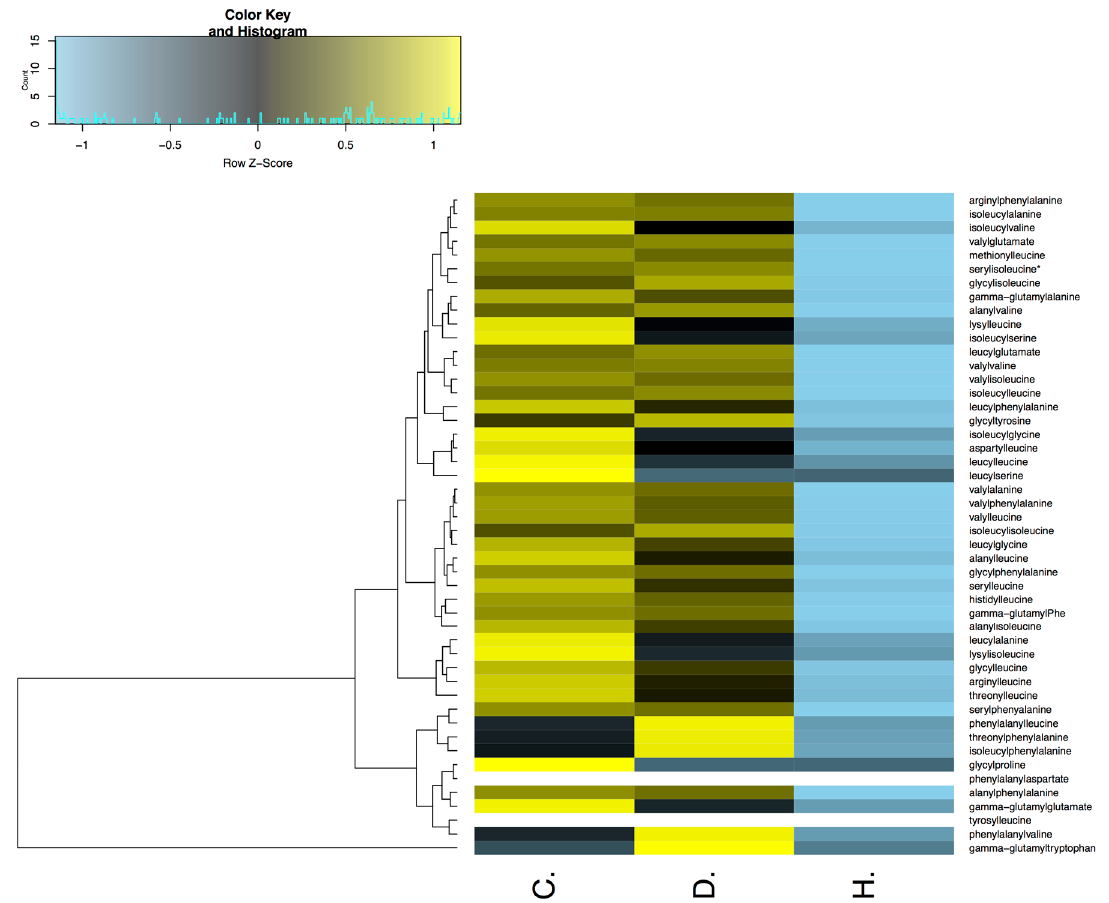
Figure 5. Differential abundance of peptides under drought and heat stresses. Heat map showing the differences in the abundance of the various peptides in soybean leaves under control (C.), drought (D.), and heat stress (H.) conditions.